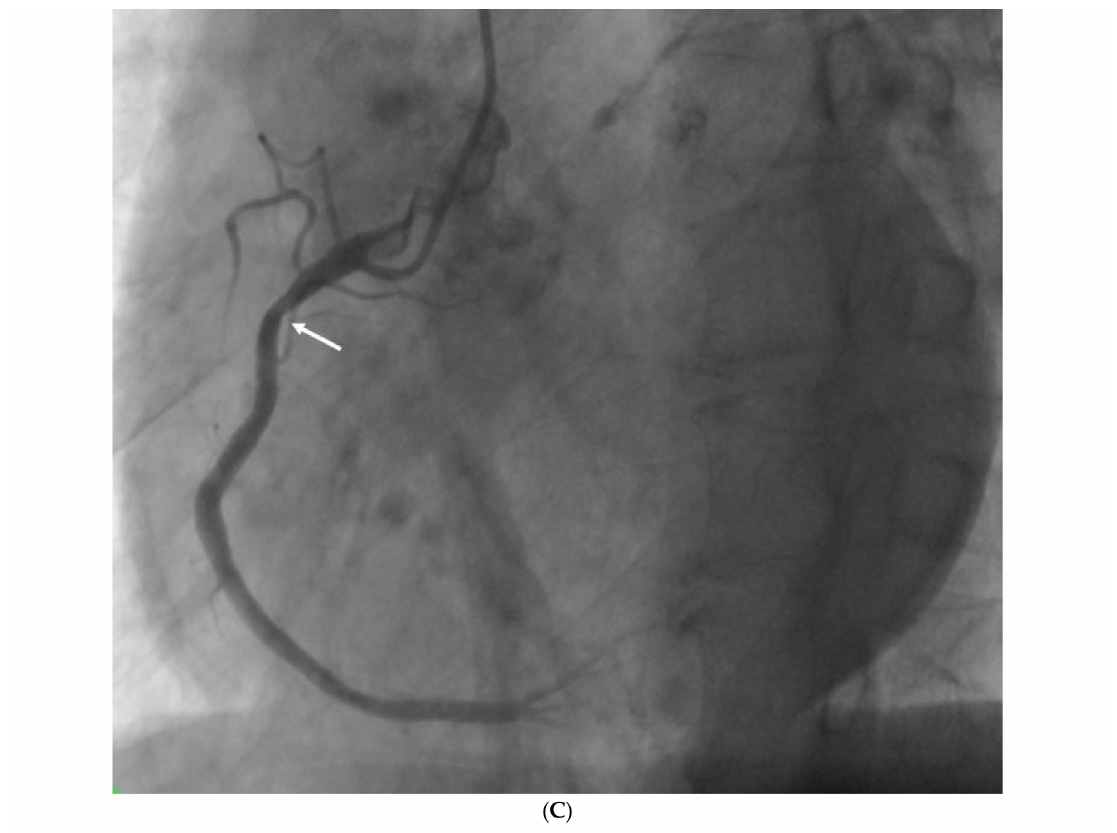
Figure 5. Multiple calcified plaques at the right coronary artery (RCA) in a 64-year-old man with coronary artery disease. ( A ): Curved planar reformatted image shows multiple calcified plaques at the RCA. Arrow refers to the plaque in the proximal RCA causing >50% stenosis that was selected for comparison of lumen differences. ( B ): Comparison of the enhanced super-resolution generative adversarial network (ESRGAN)-processed images with original CCTA in the assessment of coronary lumen stenosis caused by the plaque (arrows) as indicated in Figure 4A. The mean lumen stenosis was measured 59%, 52%, 48% and 47% at original CCTA, ESRGAN-High Resolution (ESRGAN- HR), ESRGAN-Average (ESRGAN-A) and ESRGAN-Median (ESRGAN-M) images, respectively. ( C ): Invasive coronary angiography confirms no significant stenosis with measured diameter of 33% (arrow). ESRGAN-A and M images improved the lumen assessment illustrating no significant stenosis as